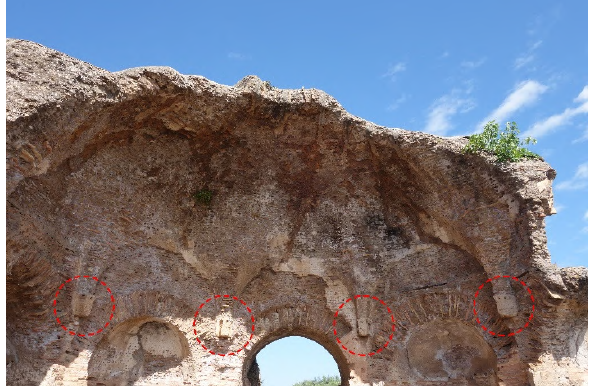
Figure 7. the Vestibule dome with pulvini highlighted.